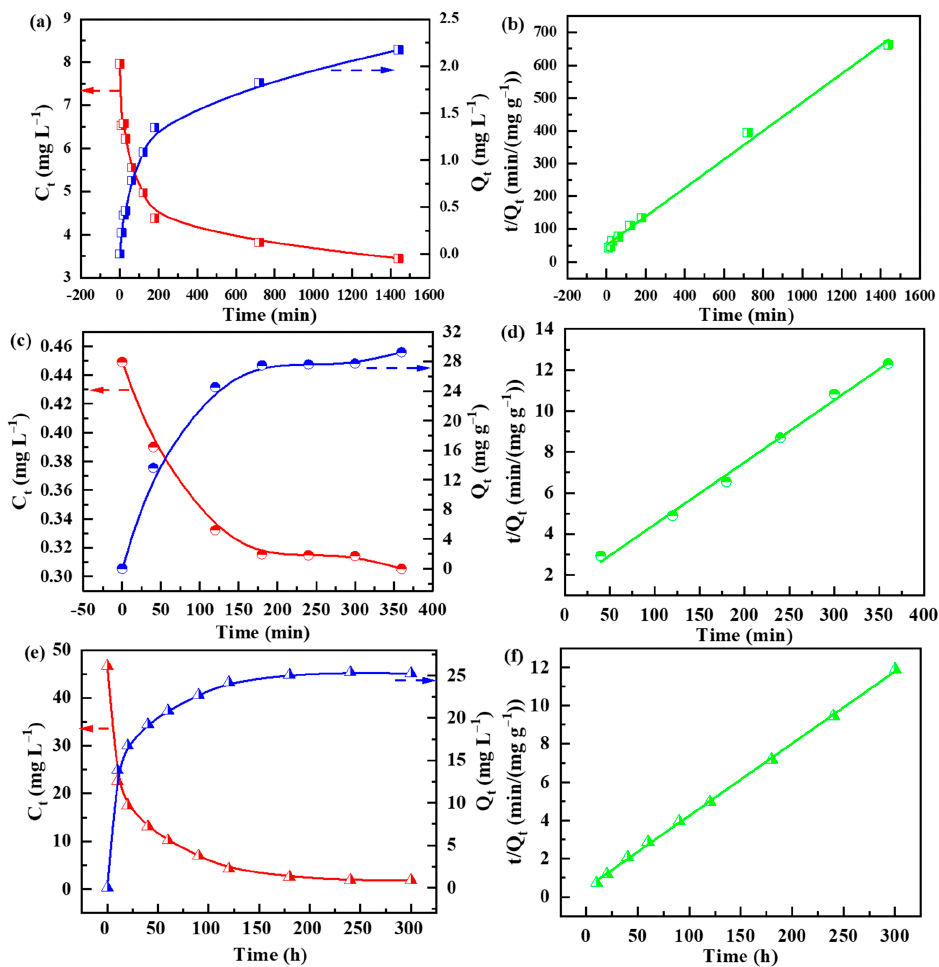
Figure 5. Adsorption kinetics of ( a ) Pb 2+ , ( c ) lysozyme and ( e ) MB by SPS foams, and ( b , d , f ) corre- sponding fitting curves obtained by the pseudo-second-order equation. (The red arrow points to the left axis, the blue arrow points to the right axis.) Table 2. Kinetic fitting results of the adsorption